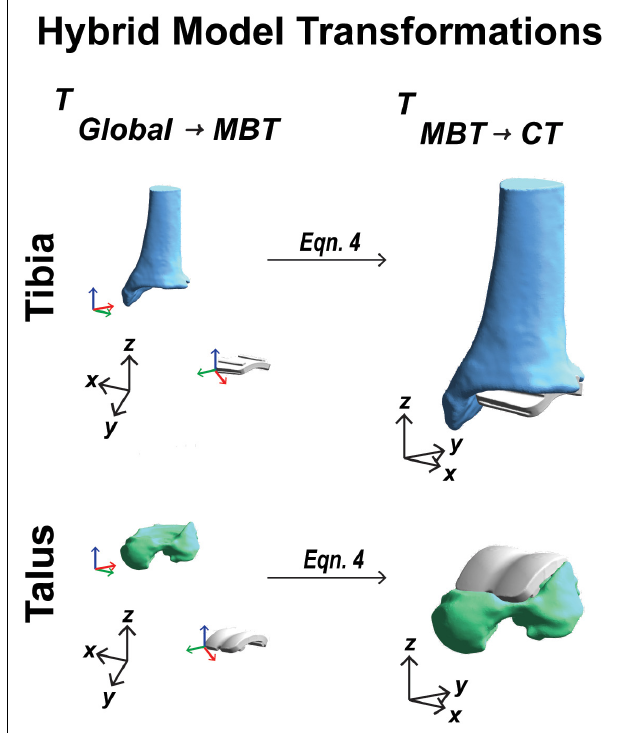
FIGURE 6 | Visual representation of the coordinate system transformations performed from global vector space, represented by black axes, through model-based tracking space to finalized CT vector space for a tibia and talar hybrid model